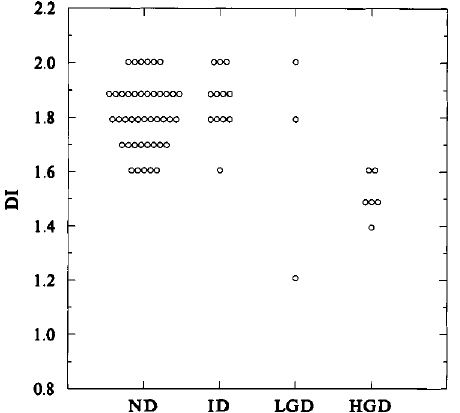
Fig. 1. DNA index (DI) in 63 aneuploid biopsy samples from 17 pa- tients with long-standing ulcerative colitis. The distribution of DI, presented as mean values of each aneuploid sampling region per pa- tient, is related to presence of high grad dysplasia (HGD), low grade dysplasia (LGD), indefinite for dysplasia (ID) and to no dysplastic findings (ND).